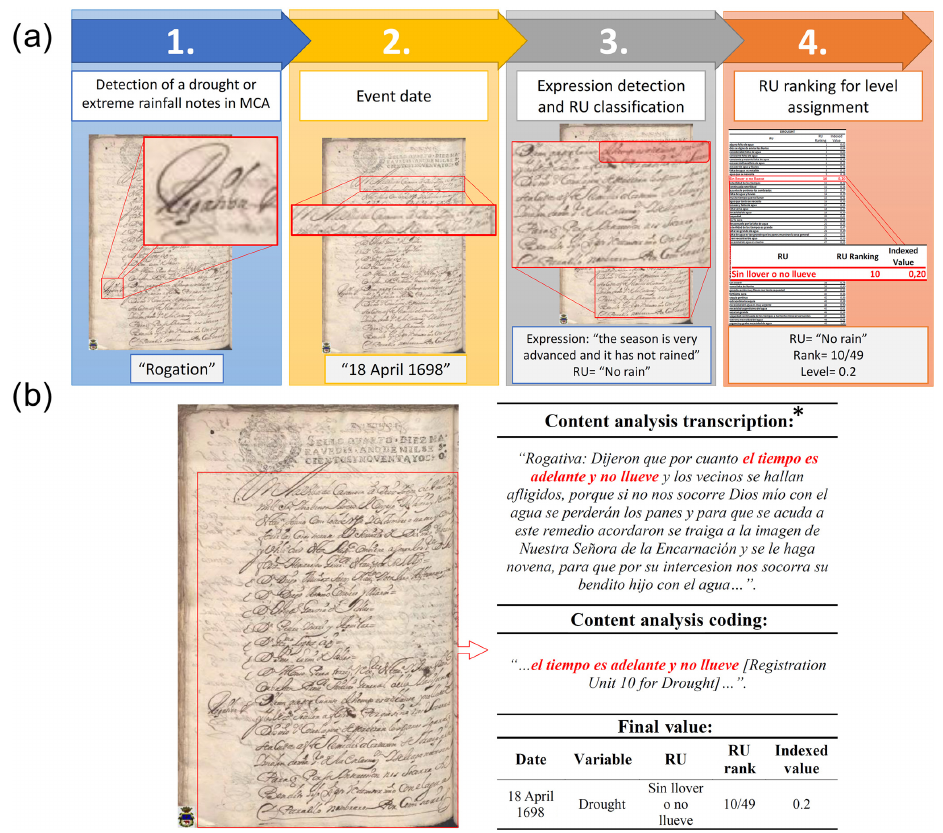
Figure 4. Content analysis method by step (a) and an example of the encoding of the CA method (b) . The coded source is the same as in Fig. 2 to emphasise how the three different approaches are applied in practice. This particular example refers to a PPR on 18 April 1698, so the reconstructed variable is drought. Source: the Carmesi Project. ∗ This text is written in Old Spanish. An approximate translation is the following: “They said that the season is very advanced and it has not rained and the population is afflicted, and unless God helps us with rain the crops will be lost. Therefore, they agreed to bring the image of “Our Lady of Encarnación” and to celebrate nine masses praying so that She asks to her Son to help us with